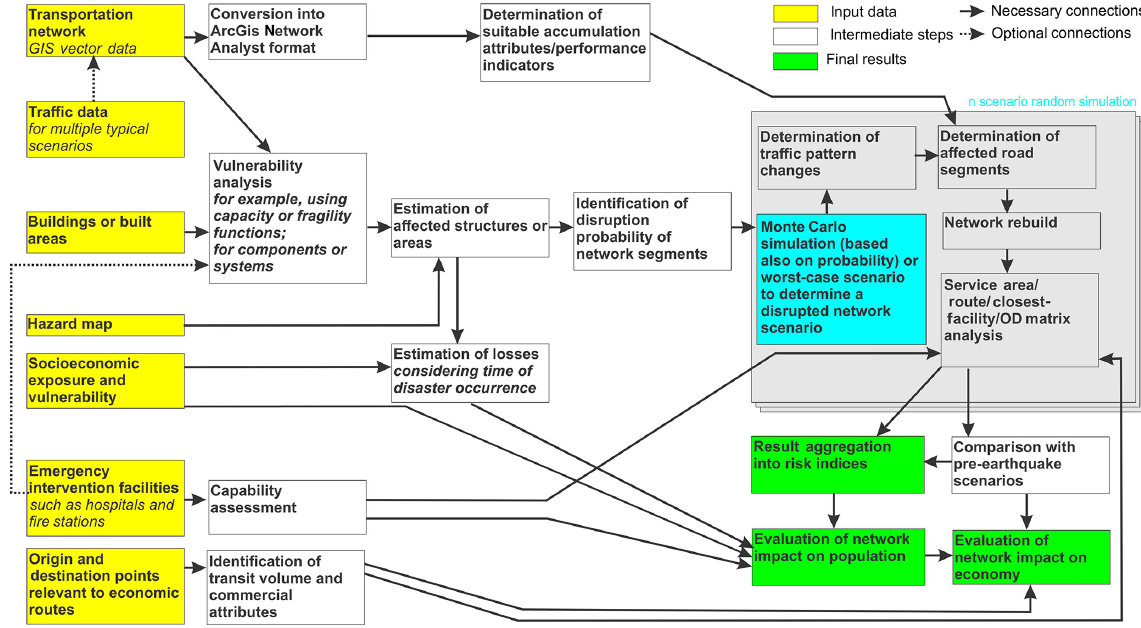
Figure 1. Graphical representation of the proposed methodology for evaluating the implications of transportation network damage due to natural hazards, integrated into the Network-risk